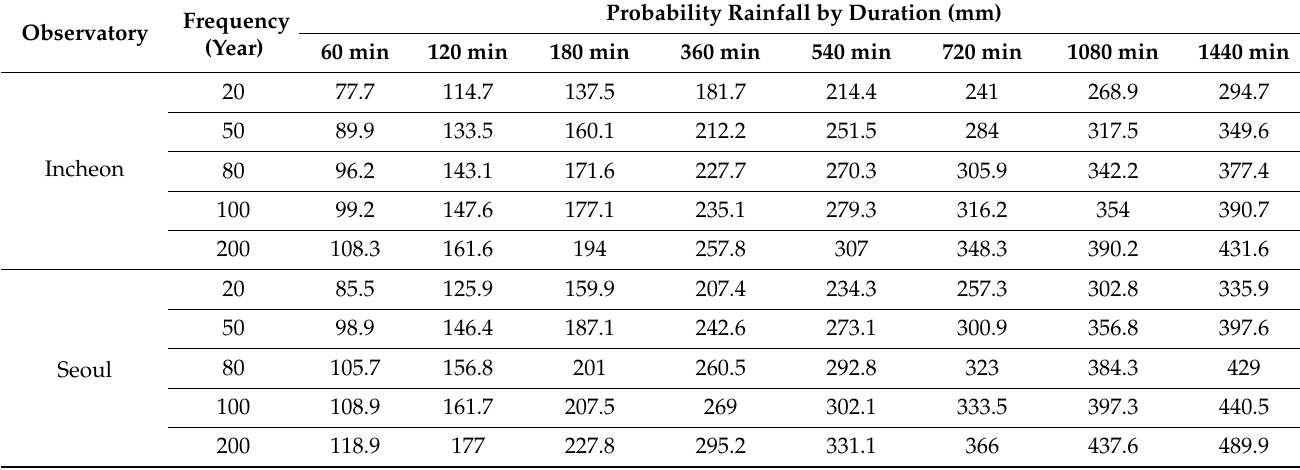
Table 4. Probability Rainfall for Each Duration and